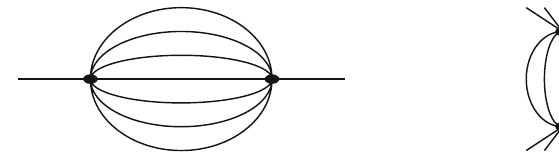
Fig. 7 Leading order topologies for φ 8